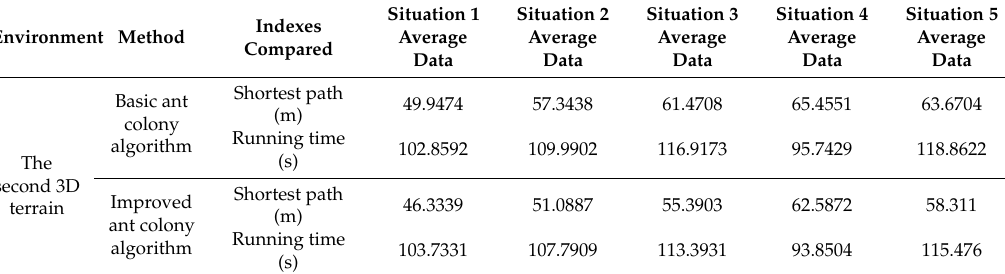
Table 4. The running data of the second 3D terrain in different